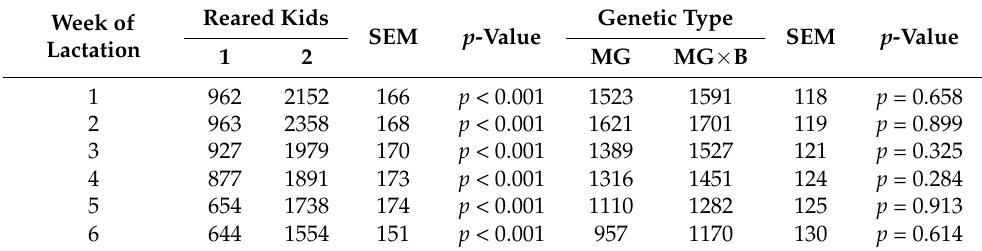
Table 3. Actual milk mean values (mL) according to the number of kids reared (1,2) and the week of lactation, in a mixed rearing system. Reared Kids Week of Lactation SEM p -Value 1 2 1 1638 764 144 p < 0.001 2 1563 773 143 p < 0.001 3 1756 972 146 p < 0.001 4 1701 1058 146 p = 0.002 2091 1911 109 p = 0.392 2212 2015 150 p = 0.991